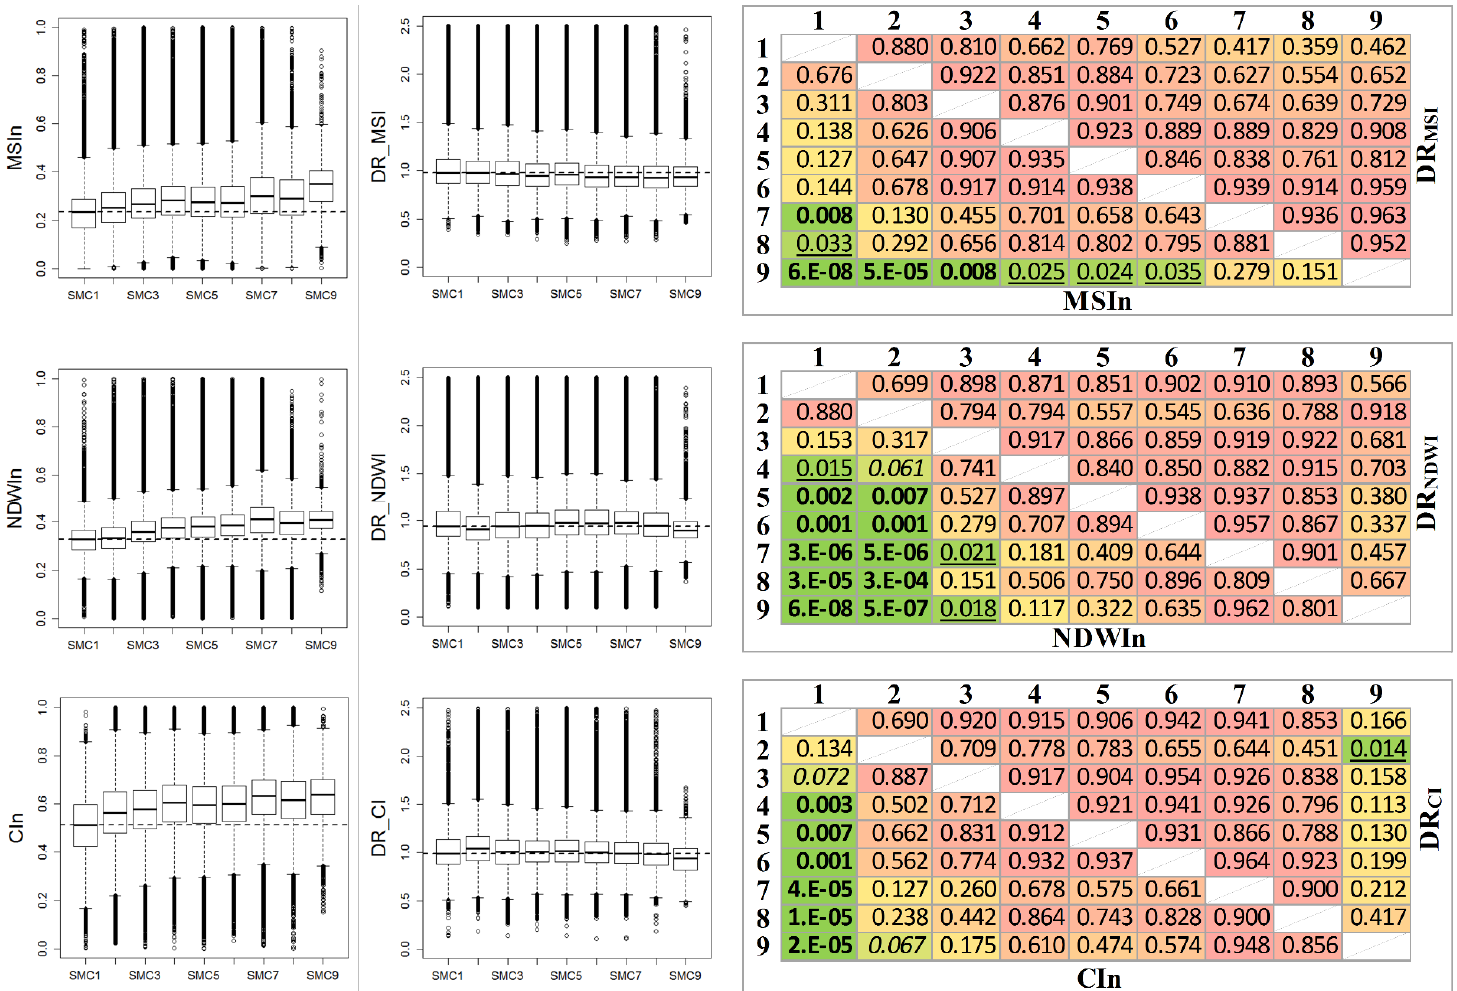
Figure 9. Comparison between SMC-specific boxplots for MSIn, NDWIn, and CIn ( left ; horizontal dashed lines represent the median of the SMC1 distribution) and the corresponding double ratio indices DRMSI, DRNDWI, and DRCI ( center ) and p -values ( right ; color scheme and character styles emphasize the significance levels (dark green/bold: 1%, green/underlined: 5%, yellow/italics: